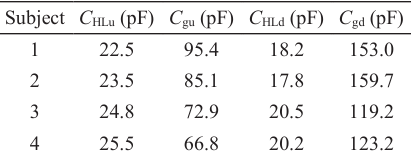
Table 2. Capacitance C HL measured with the 4294A impedance analyzer and calculated body capacitance to ground C g for the four subjects and two feet heights above to ground: 10 cm (u) and direct outsole contact (d).